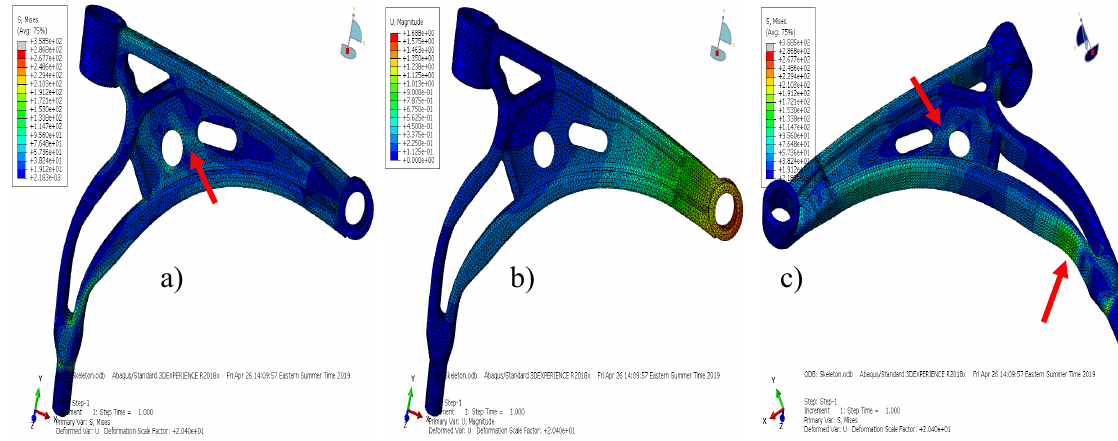
Figure 9. FEA of hollow design; ( a ) von Mises stress plot, ( b ) total displacement plot, ( c ) other view of Von Mises (VM) stress plot.